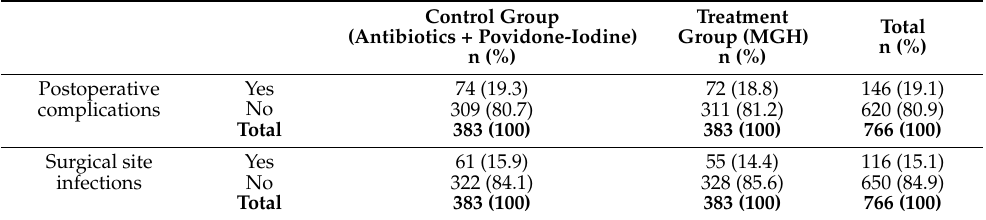
Table 2. Overview of the number and percentage of postoperative complications and surgical site infections following CS. Data are presented per group (control, treatment, or total).